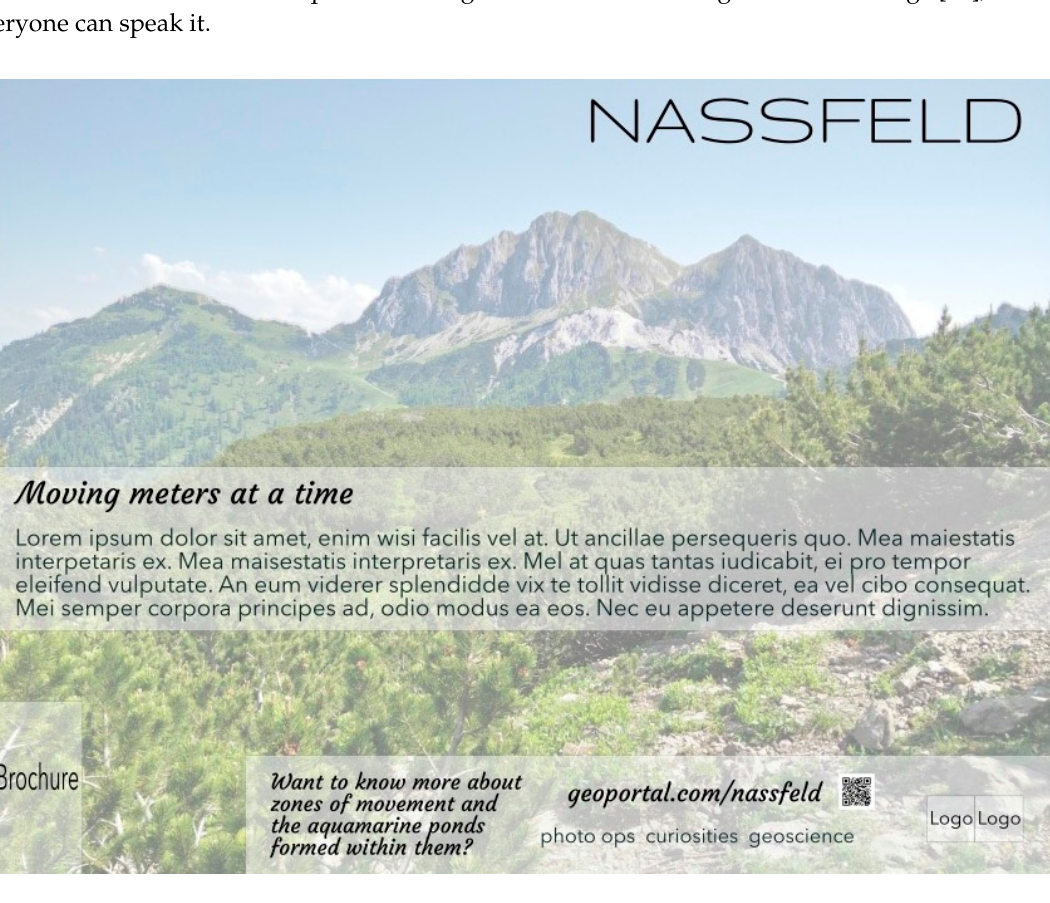
Figure 6. A mock-up of the sign template. Latin was used for the body since interpretive text is outside of the scope of this paper. The title was written to introduce the topic of deep time to the latent geotourist in a dramatic fashion for a strong first impression [65]. It refers to slope movements, which measured up to one meter a year in parts of the Reppwand-Oselitzenbach sagging zone [2]. The reason the photo is opaque is to solve the problem of sign placement sometimes encountered by the visitor who does not know where to look [46]. It directs the eye but makes the landscape itself the focus, not the photo. The format employs chunking so it does not overwhelm the viewer with text even when several signs are displayed on site. One could be printed for each of the ABCs, allowing one to follow the blended approach some markets demand. The finished sign is meant to be double sided to accommodate international venues with bilingual signs. The size of the sign follows ISO standard A1 or A2 (594 × 841 mm or 420 × 594 mm, respectively). A brochure is attached or available nearby. The author used her working name for the sign concept, ‘geo-portal,’ as a placeholder for the website link in the graphic.